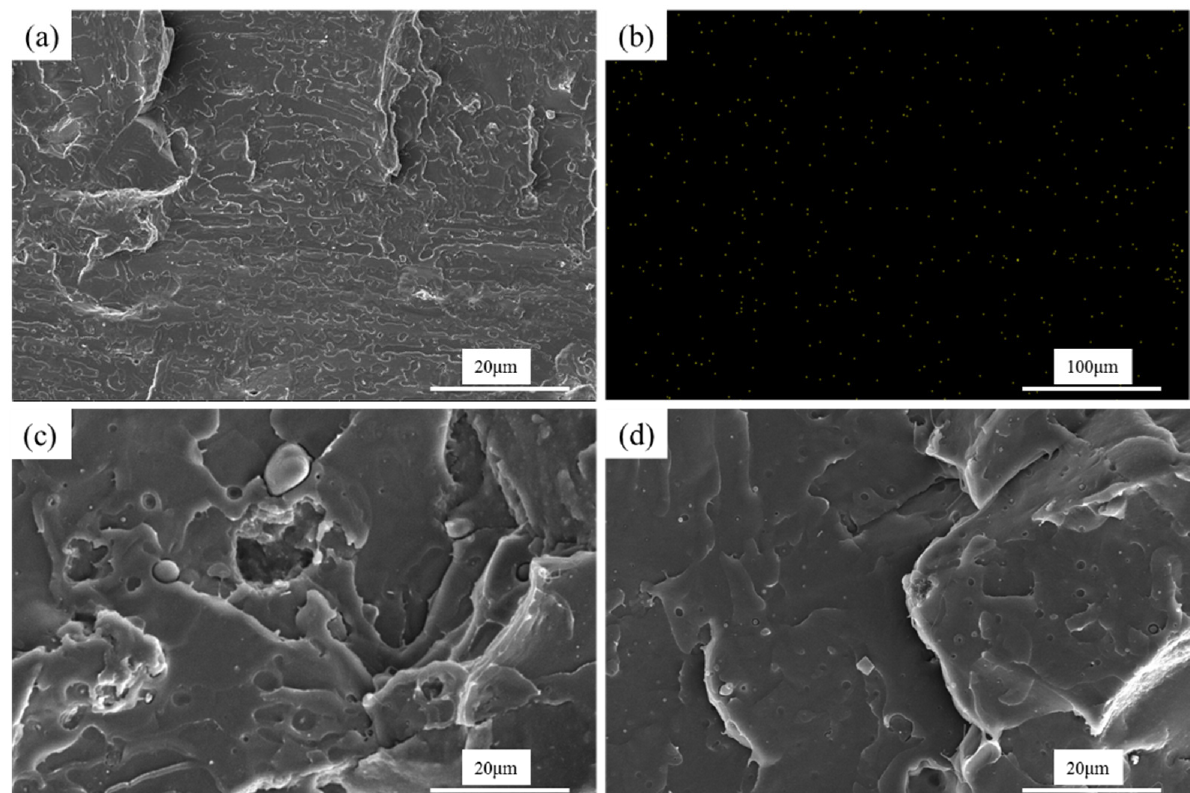
Figure 8. SEM images of cryofracture surfaces of ( a ) neat PLA. ( c ) PLA/GTR5. ( d ) PLA/GTR5-D1.0, and ( b ) EDX maps for PLA/GTR5.